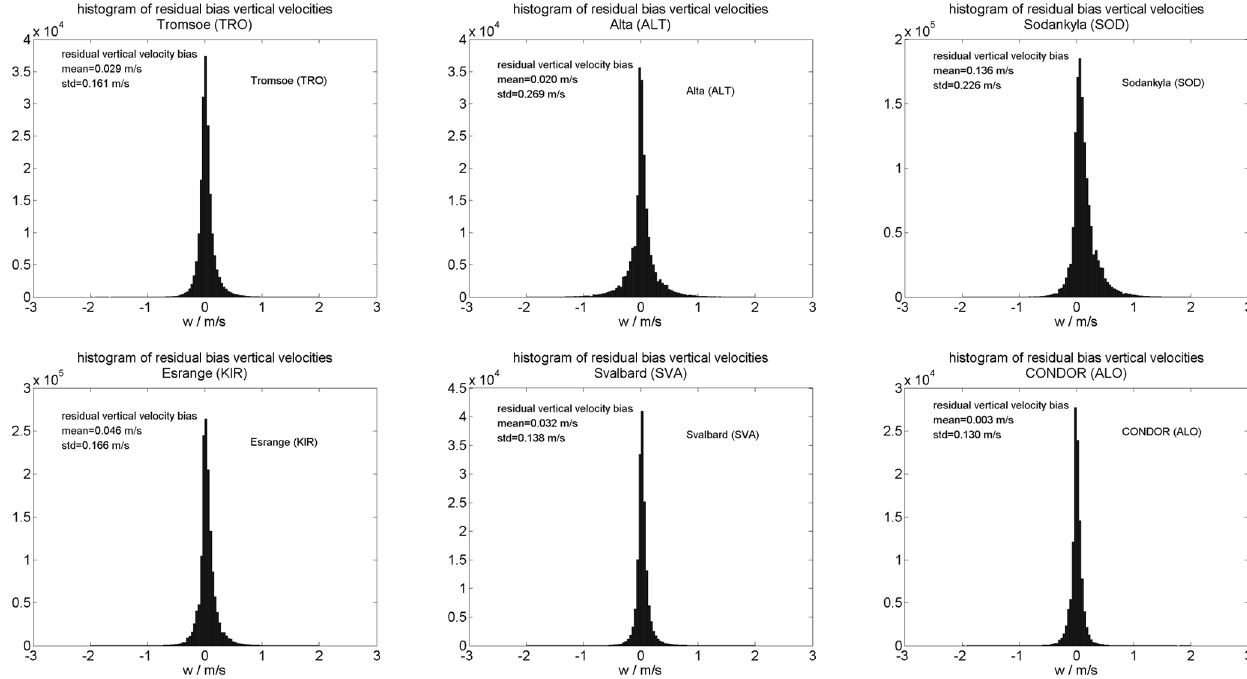
Figure 2. Histograms of the residual vertical wind bias for TRO, ALT, SOD, KIR, SVA and ALO